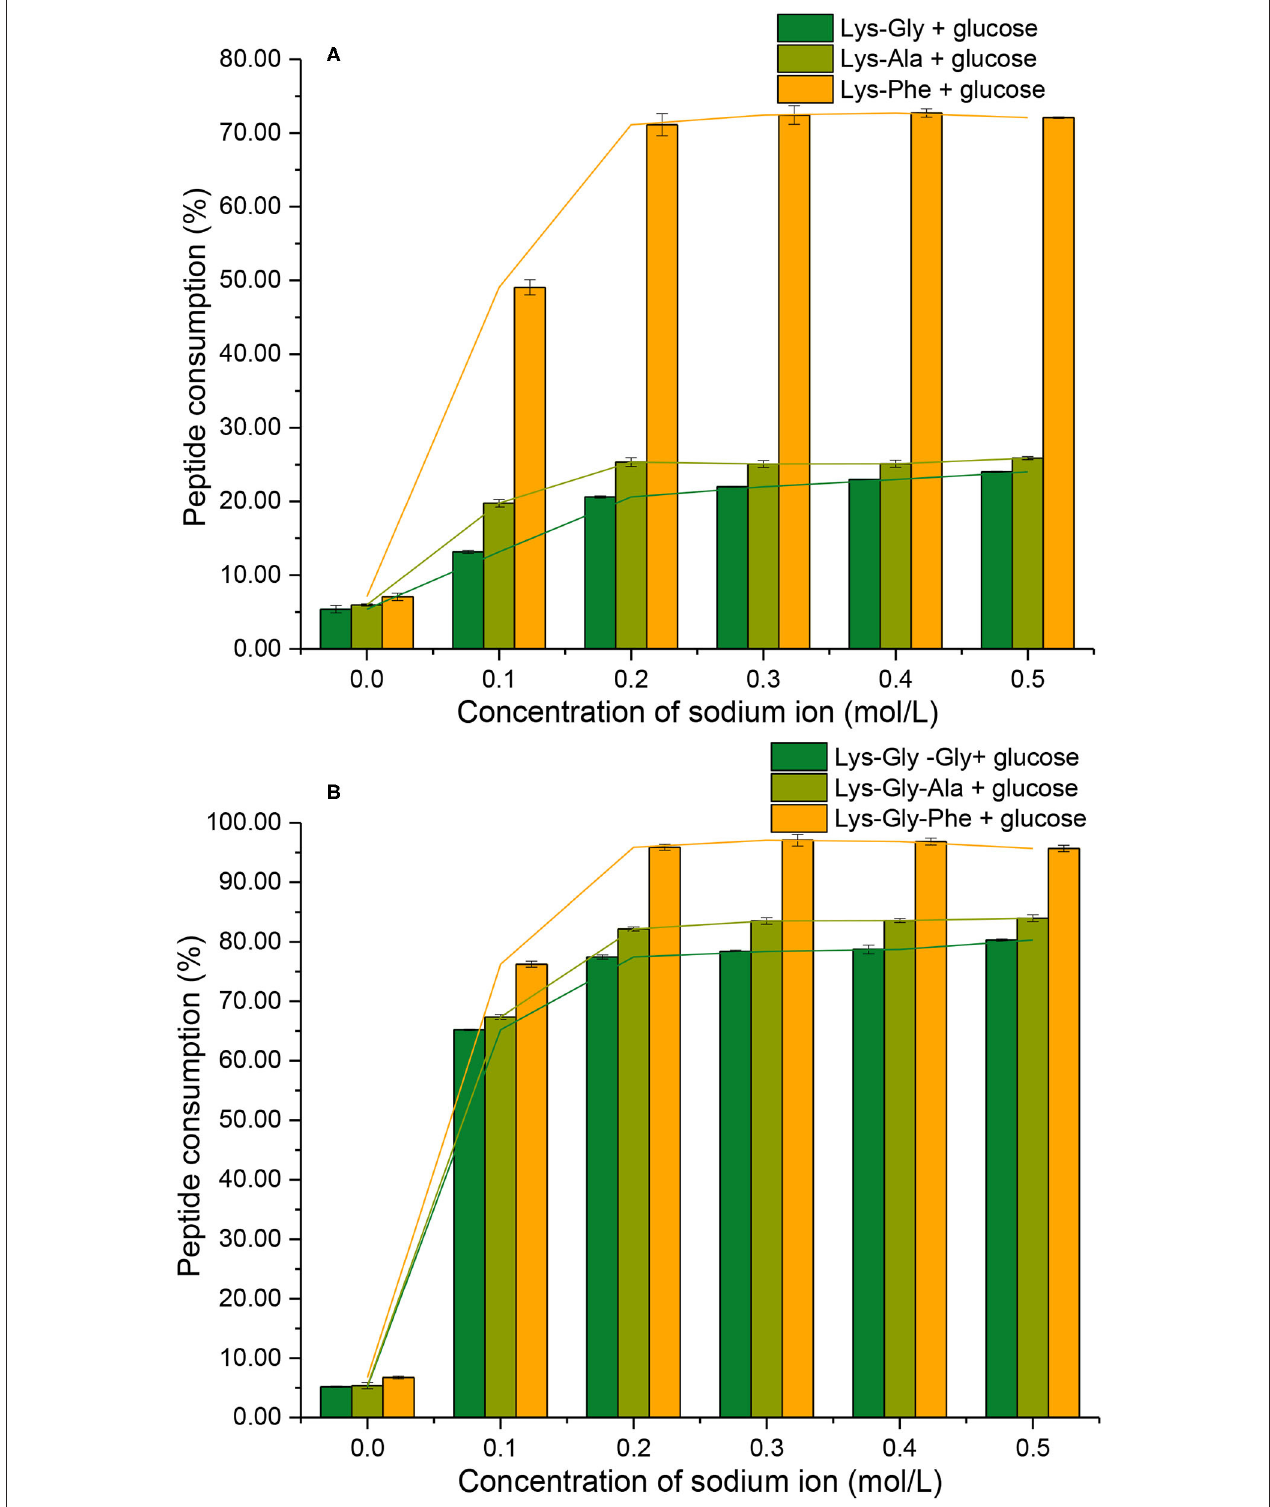
FIGURE 7 | Peptide consumption after the Maillard reaction of peptides with glucose at different sodium ion concentrations [ (A) : in the mixtures containing dipeptides; (B) : in the mixtures containing tripeptides].